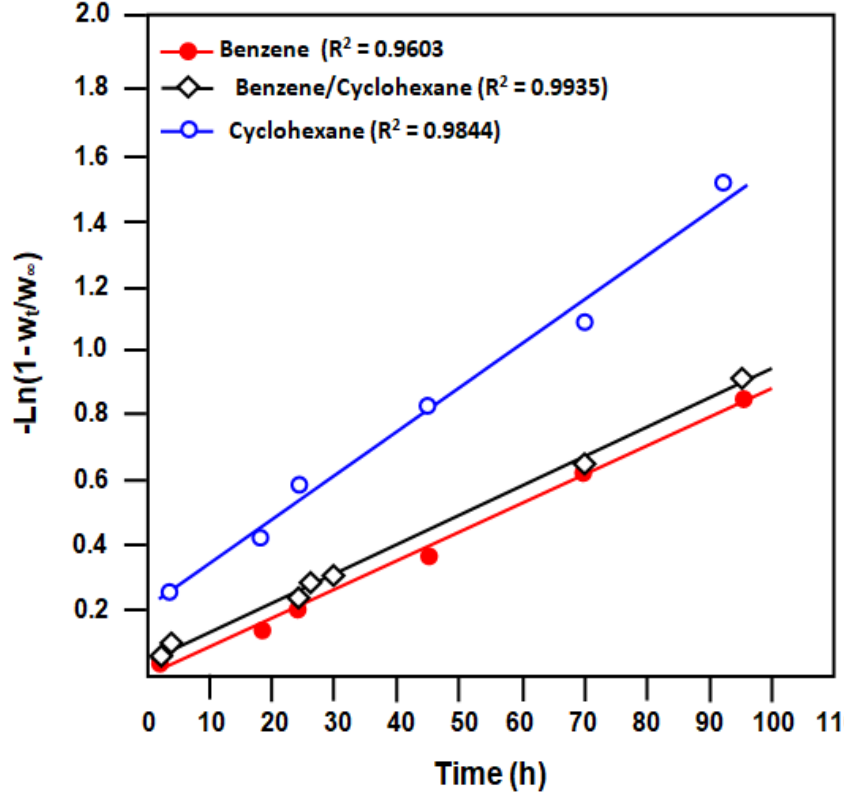
(cid:104) (cid:105) 1 − w t of the E-VOH membrane in benzene, cyclohexane, and their w t ∞ (cid:4675) of the E-VOH membrane in benzene, cyclohexane, and their (cid:3050) (cid:3295)(cid:3246)